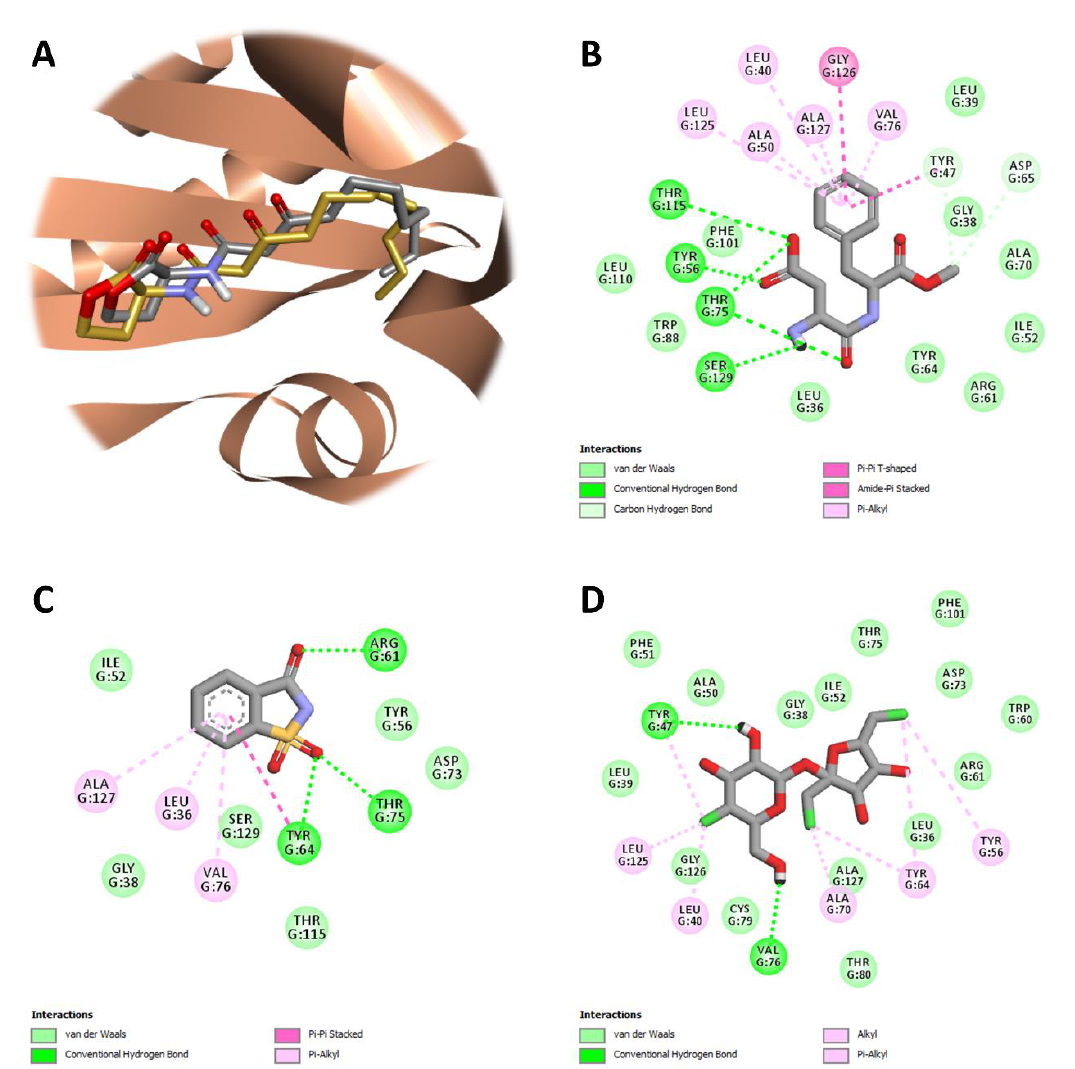
Figure 5. Protein-ligand docking and interaction profiling. ( A ) Close-up view of the superposed structures of co-crystallized (gold) and redocked (silver) 3-oxo-C12-HSL in the ligand-binding cavity of LasR (PDB ID: 2UV0; chain ID: G). Favorable non-covalent interactions stabilizing the relative position of ( B ) aspartame, ( C ) saccharin, or ( D ) sucralose with respect to the LasR-LBD. Images were prepared and rendered using Discovery Studio Visualizer, version 16.1.0 (Dassault Systèmes BIOVIA Corp., San Diego, CA, USA).